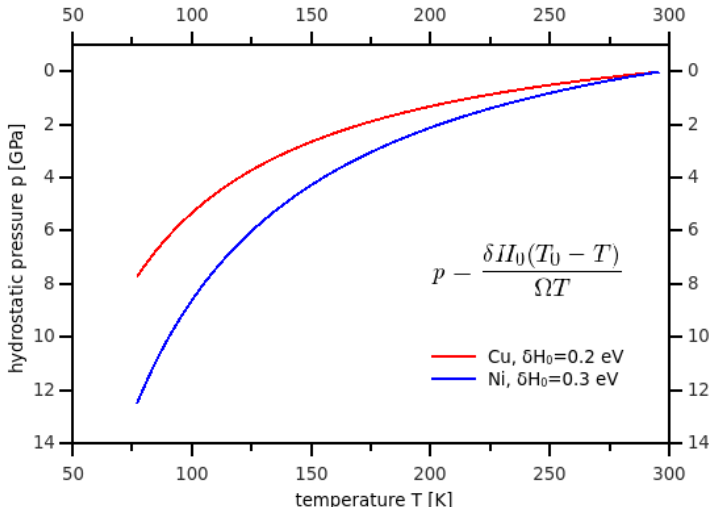
Figure 1. The evaluated temperature-to-pressure equivalence for the dependence of the vacancy migration enthalpy according to the Arrhenius exponent and Equation (1) for the investigated